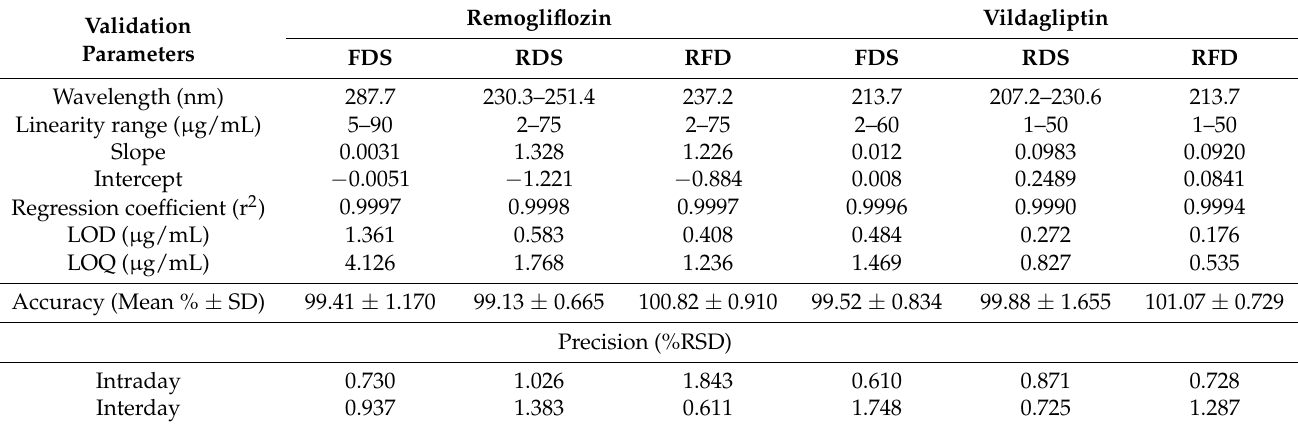
Table 1. Validation parameter results of the proposed spectroscopic methods for the simultaneous determination of VGN and